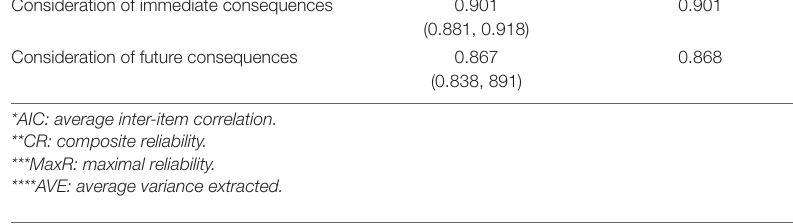
TABLE 4 | Discriminant validity assessment using the Fornell–Larcker criterion and HTMT matrix.